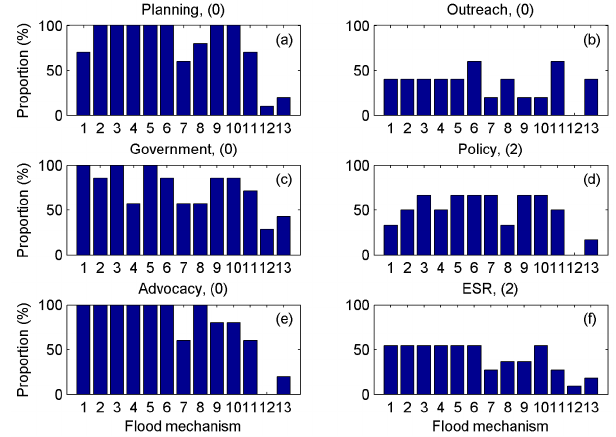
Figure 2. Socioeconomic losses that defined flooding events by dis- cipline (Table 2 subset by discipline). Values in parentheses indicate the number of respondents who did not offer an